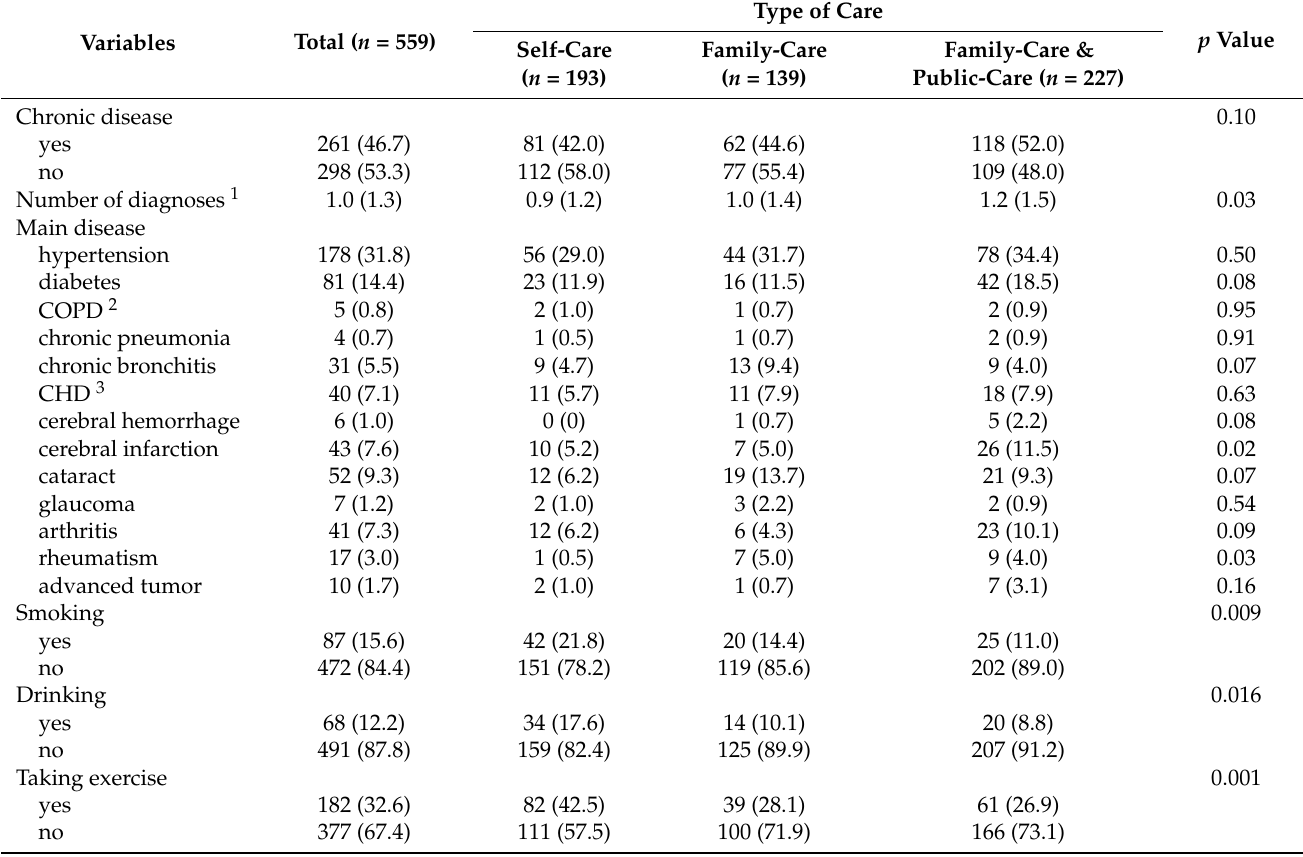
Table 2. Disease status and health behaviors of disabled elderly in different types of